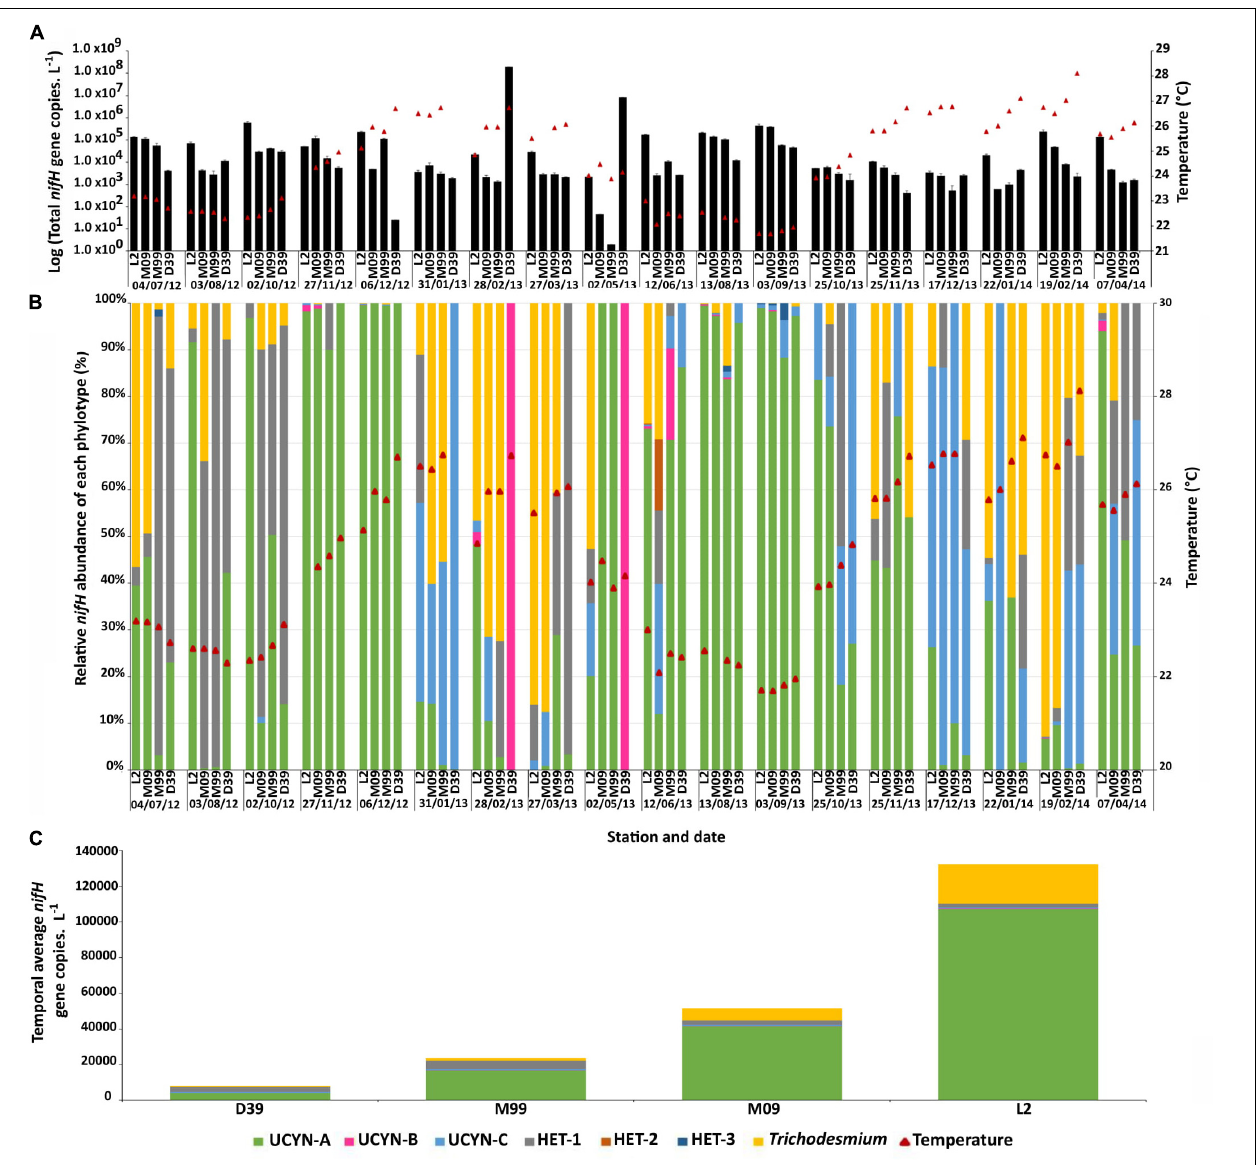
FIGURE 4 | Temporal dynamics of total nifH gene counts L − 1 over the survey in surface waters (A ; the errors bars correspond to the errors propagation from triplicate analyses), relative abundance of each diazotroph phylotype targeted in this study and sea surface temperature (SST, red triangles; B ), and average nifH counts L − 1 over the survey per target group and per station (C)